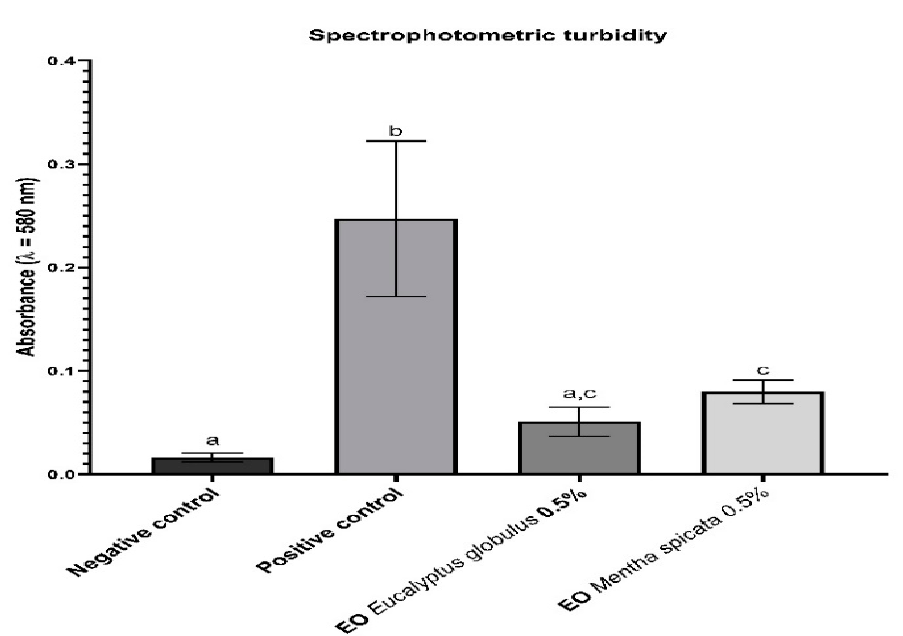
Figure 3. Spectrophotometric turbidity.